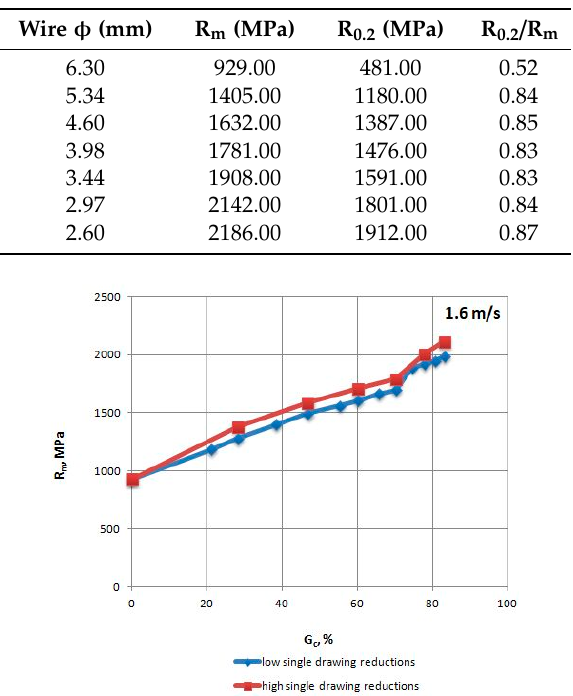
Table 7. Results of tests regarding the mechanical properties of TRIP steel wires drawn as per variant D (V c = 6.0 m / s, high single drawing reductions).